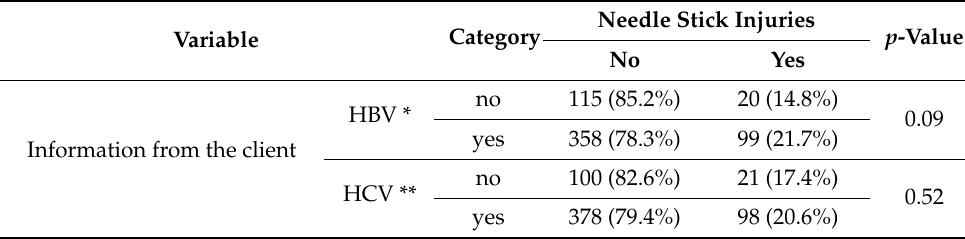
Table 3. Awareness and the risk of infections among beauticians from clients’ information about current/past infectious diseases (for example, viral diseases) and needle stick injuries.